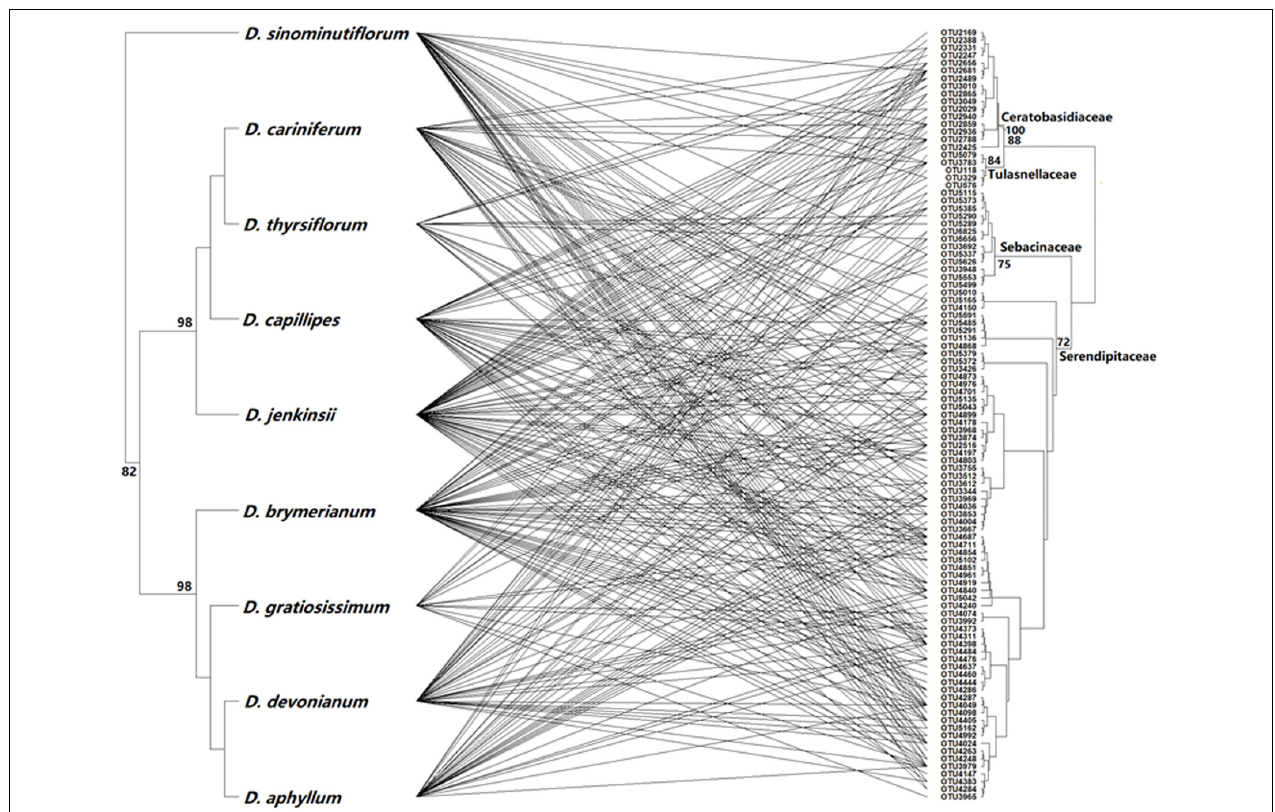
FIGURE 3 | Interaction network between the co-occurring Dendrobium species and mycorrhizal fungi. The network shows all links between nine Dendrobium species and 101 mycorrhizal fungal OTUs (285 binary links in total). Branch support values ( ≥ 70) above the branches are maximum likelihood non-parametric bootstrap